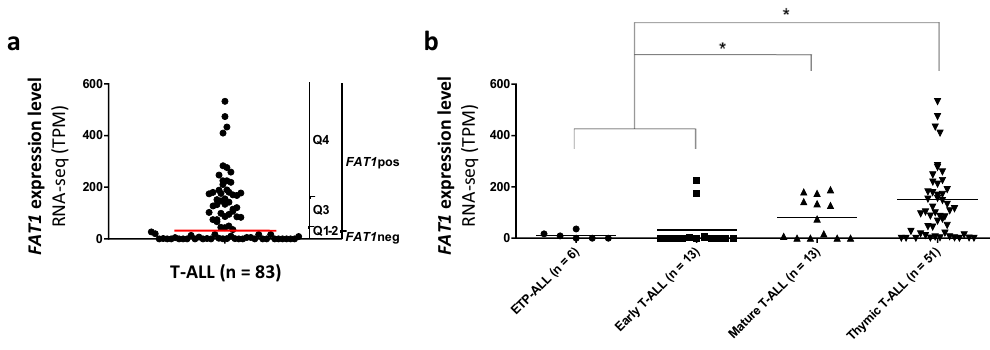
Figure 1. Aberrant FAT1 expression in T-ALL ( a ) FAT1 expression data analyzed by RNA-seq (HighSeq 2000, 125 bp, ~ 30 million reads/sample) was available for n = 83 diagnostic T-ALL samples from adult patients (median age 32 years, range 17–59 years; including n = 19 early T-ALL and ETP-ALL, n = 51 thymic T-ALL and n = 13 mature T-ALL. FAT1 positivity was considered by a cutoff at Transcripts Per Million (TPM) 30 defining those two groups with high (FAT1pos, n = 45, median TPM 155, range 36–1368) or very low/negative FAT1 expression (FAT1neg, n = 38, median TPM 0.5, range 0–27). T-ALL patients were subdivided into quartiles according to expression. Q1-Q2 represented FAT1 negative or FAT1 very low and Q3-Q4 FAT1 high expression. One outlier (TPM 1368) was removed from the diagram but included in statistical analyses. ( b ) FAT1 expression varied between phenotypical T-ALL subgroups. FAT1 expression was significantly higher in mature (54% FAT1pos) and thymic T-ALL (69% FAT1pos) compared to early-/ETP-ALL. (16% FAT1pos; *p <